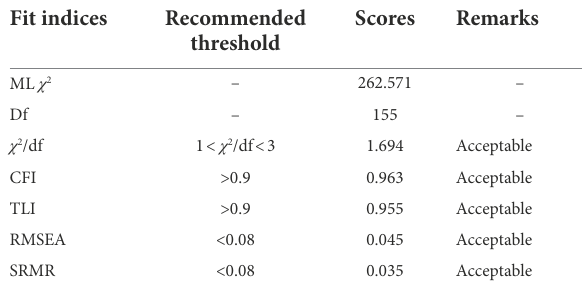
TABLE 3 Fit indices of the model.